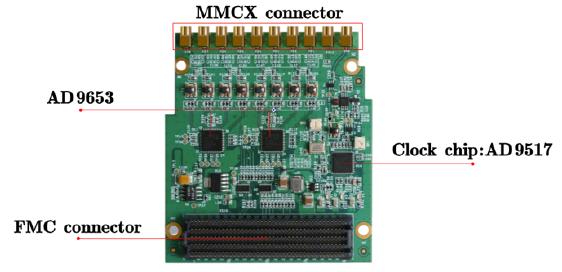
Figure 9. ADC acquisition card.